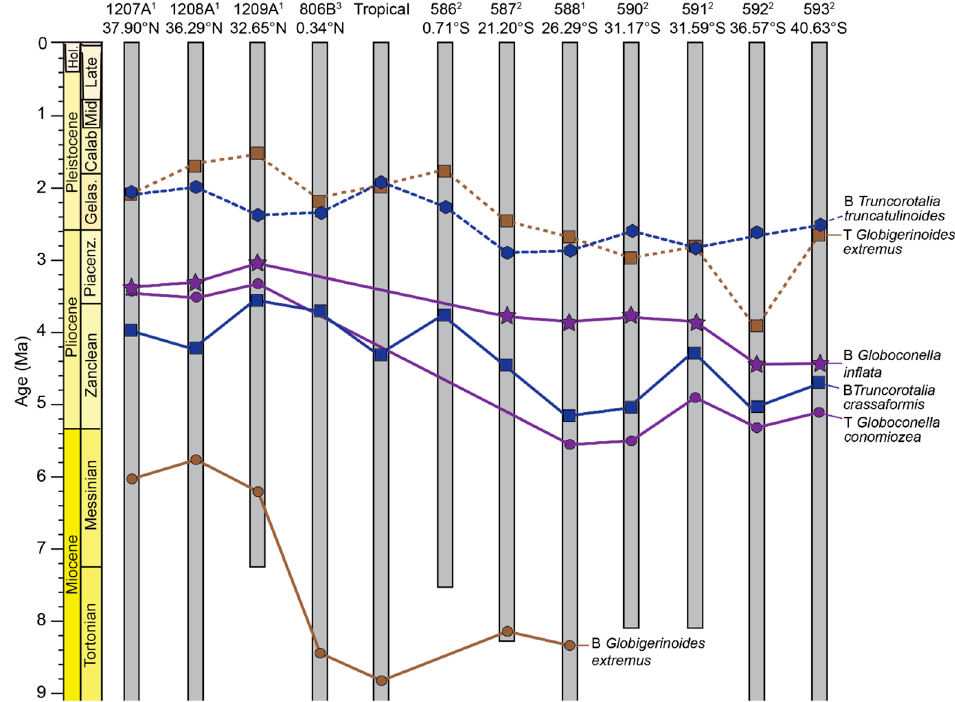
Figure 9. Select datums that exhibit diachroneity between regions, but reduced diachroneity within regions. Of note are the two styles of dispersal: more gradual dispersal from south to north (base of Tr. truncatulinoides , top of Gs. extremus , base of Tr. crassaformis ), and dispersal from the southwest Pacific into the northwest Pacific that occurs in a stepwise fashion across the tropics (base of Gc. inflata , top of Gc. conomiozea , base of Gs. extremus ). We have left out the base of Gc. inflata at Hole 806B, as these specimens were very rare, and also removed the bases of Gs. extremus at Sites 592 and 593, as we suspect that these are anomalous datums.